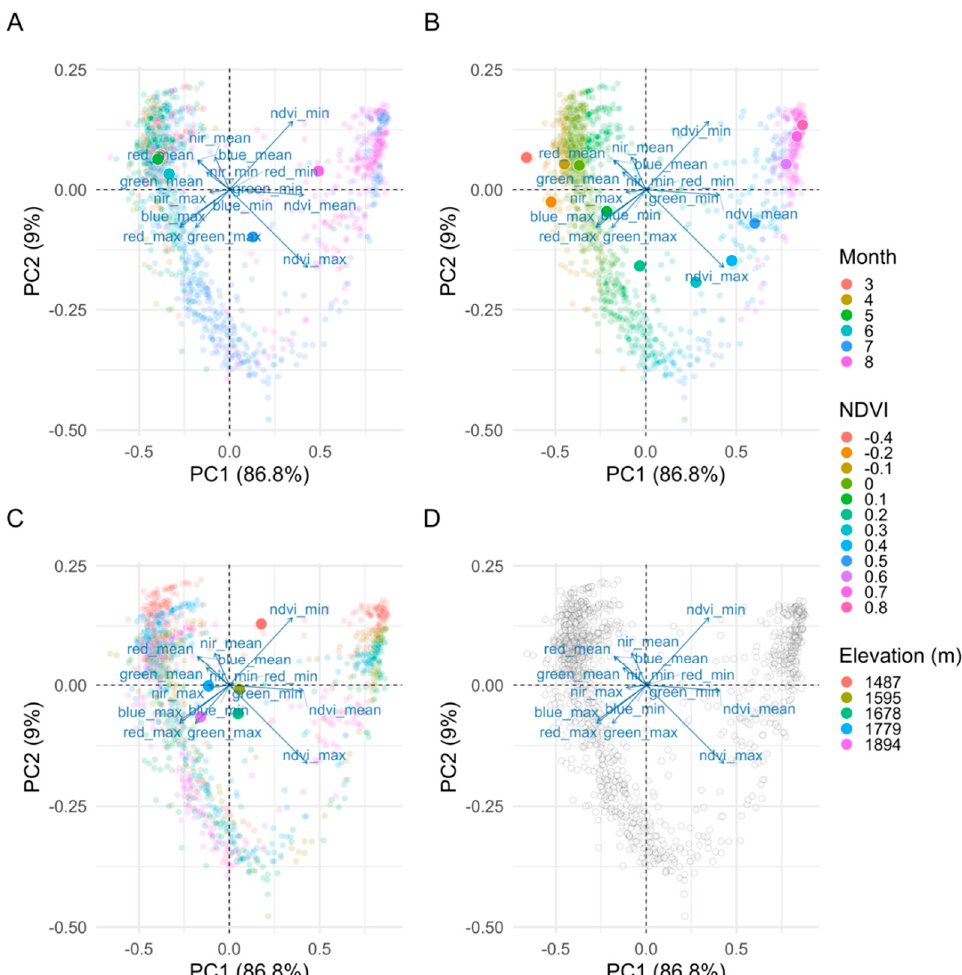
Figure 5. Biplot ordination from the principal component analysis (PCA) for 2 years (2017 and 2018) of spectral data from PS for the 5 meadow sites. ( A – C ) PC1 and PC2, overlain with the centroid (filled large dots) and average summary reflectance’s captured in visible and near infrared (NIR) bands colored by month, NDVI, and elevation (blurry dots); ( D ) the ordination without any highlighting of the individual summary reflectance’s. ( A ) Seasonal trends are evident; snowmelt in the meadows to flowering from upper left to upper right in the panel; blurry dots are colored by month. ( B ) Flowering months (late July and August) demonstrate higher positive mean values of NDVI in panel; blurry dots are colored by NDVI. ( C ) Flowering at sites showing the spread by elevation explained by increase in NDVI in the flowering months; blurry dots are colored by elevation of the meadow. ( D ) Strong correlation between visible bands, and NDVI metric that is orthogonal to NIR/visible bands.